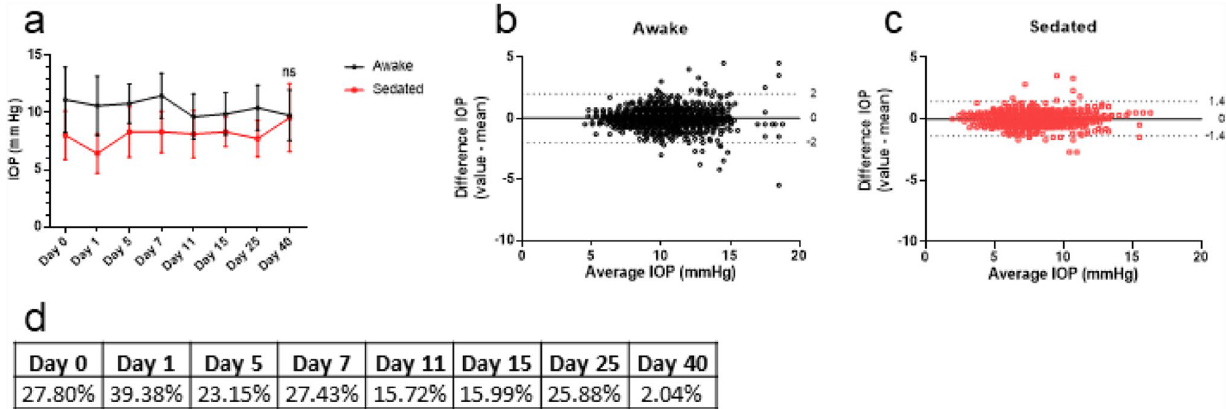
Figure 6. Effect of sedation on IOP. Measurements taken by the same observer using the TonoVet. ( a ) IOP over time in both awake and sedated rabbits. ( d ) Percentage difference in IOP between awake and sedated rabbits. ( b , c ) Bland and Altman plot from the awake and sedated rabbits. Dotted lines show 1.96 times the SD (95% confidence interval). ns; not significant.